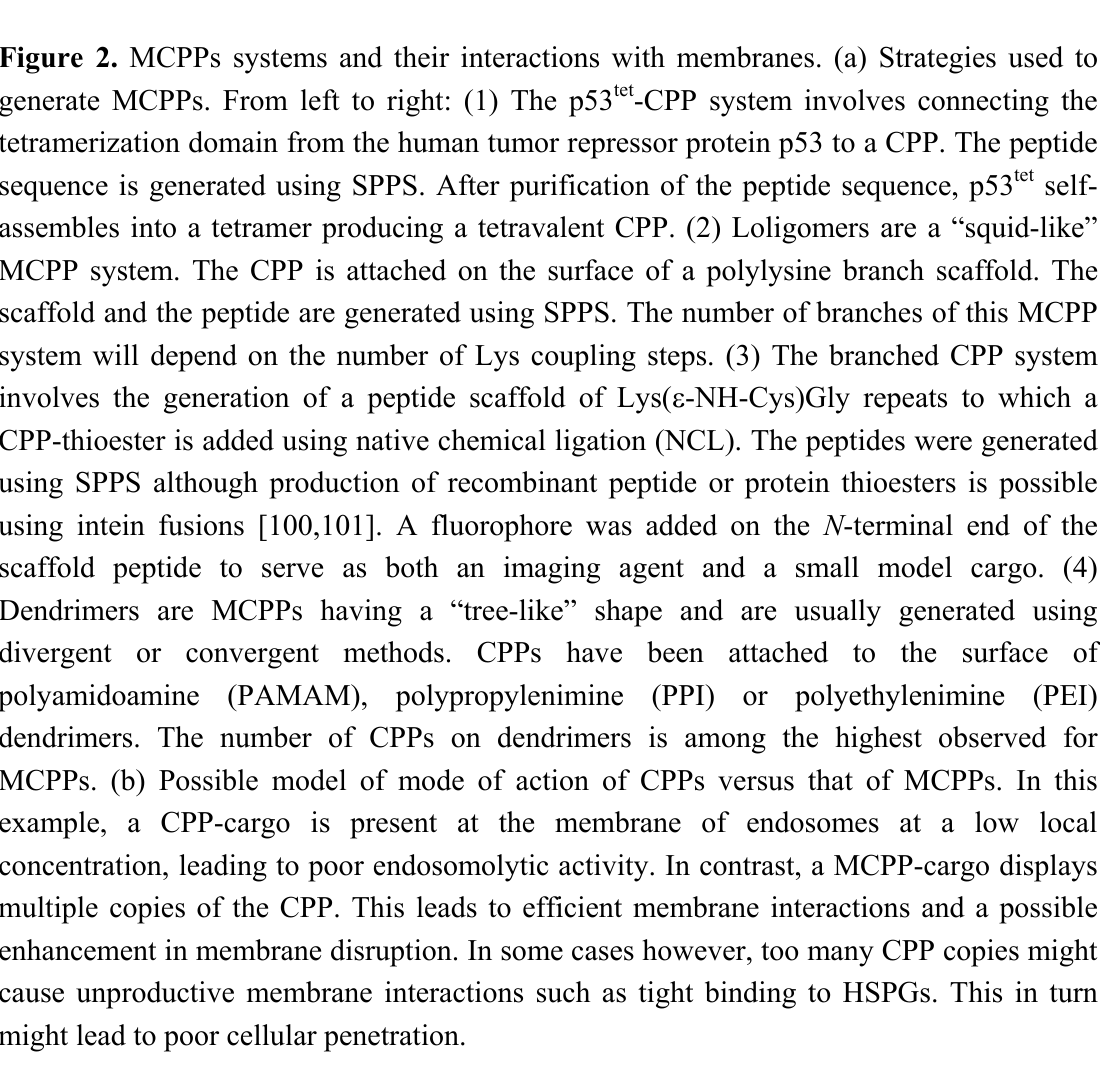
multiple copies of the CPP. This leads to efficient membrane interactions and a possible enhancement in membrane disruption. In some cases however, too many CPP copies